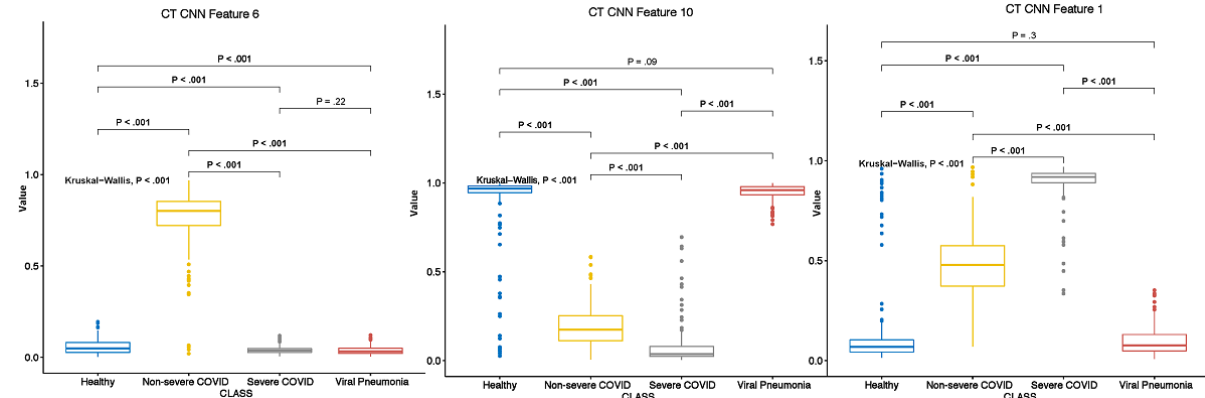
Figure 4. Multiple comparisons of the top differentiating CT features in the CNN. CNN: convolutional neural network; CT: computed